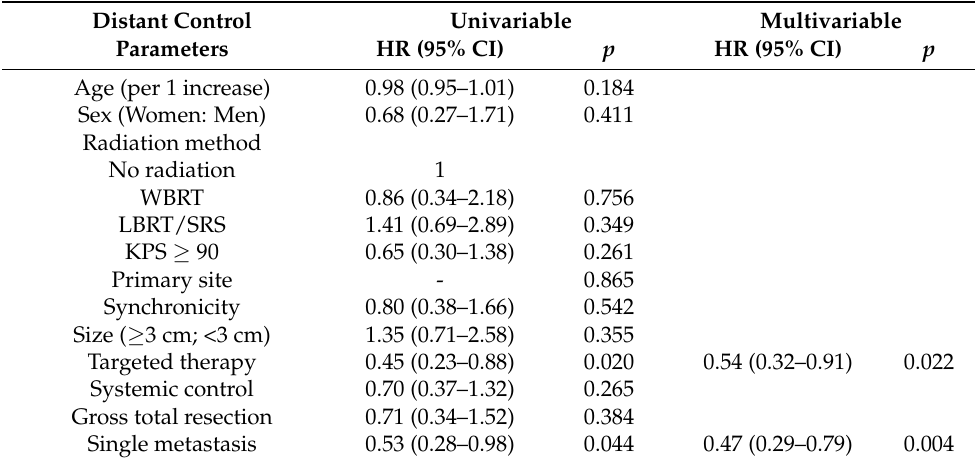
Figure 2. Kaplan–Meier curves of local control (LC) in months among 124 patients. The median LC values in each group were as follows: ( A ) radiation therapy, mean local recurrence ‐ free survival time was 71.6 vs. 40.4 vs. 33.7, (LBRT/SRS vs. WBRT vs. No radiation, respectively p = 0.022) ( B ) extent of resection, mean local recurrence ‐ free survival time was 64.4 vs. 24.6 (GTR vs. STR), respec ‐